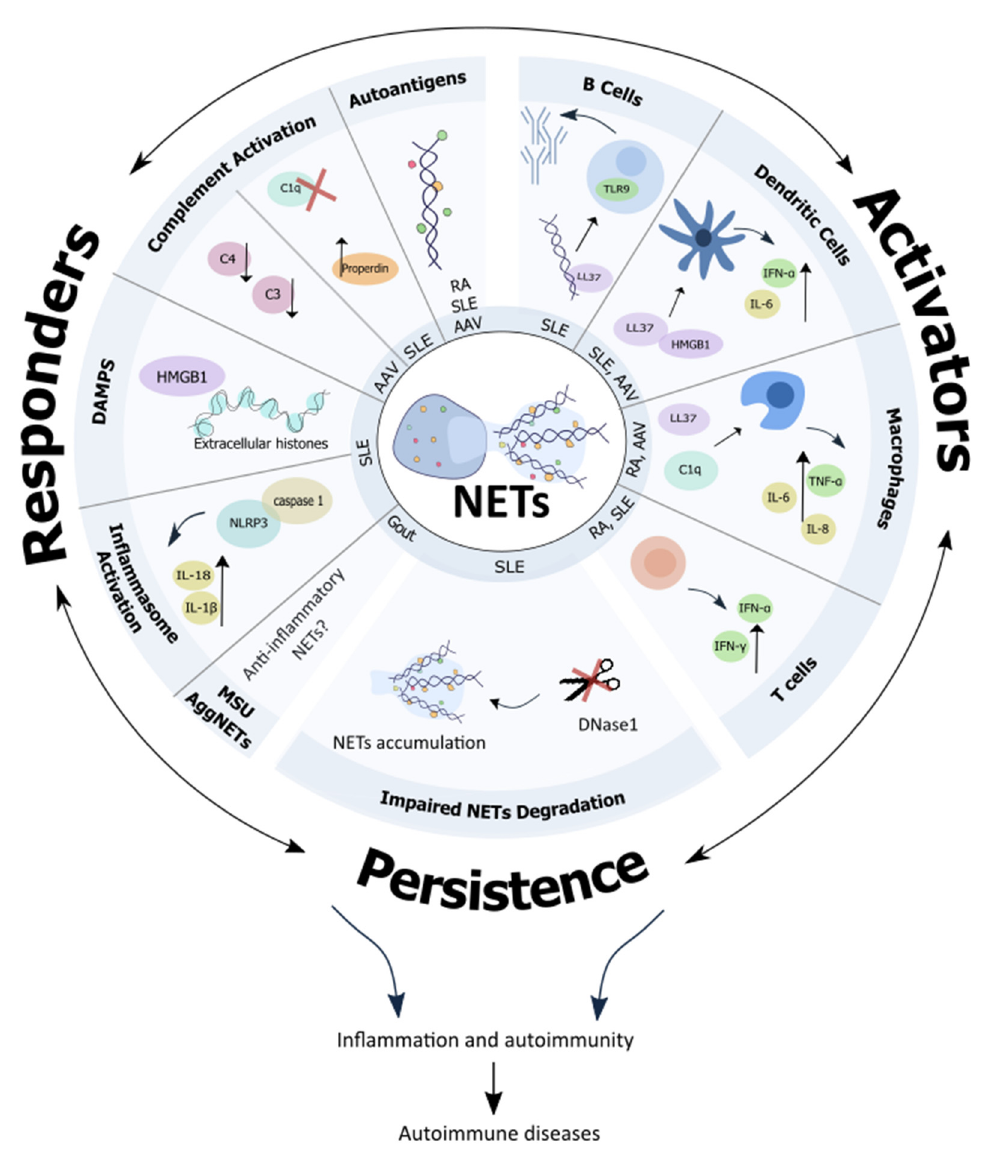
Figure 1. Neutrophil extracellular traps (NETs.) take the central stage in driving autoimmune responses. Abbreviations: AAV: Anti-neutrophil cytoplasmic antibodies associated vasculitis, ANCA: Anti-neutrophil cytoplasmic antibodies, C1q: complement factor 1q, C4: complement factor 3, C4: complement factor 4, DAMPs: damage associated molecular patterns, HMGB1: high mobility group box protein 1, IFN- α : interferon alpha, IFN- γ : interferon gamma, IL: interleukin, LL37: cathelicidin antimicrobial peptides, MSU: monosodium urate crystals, NETs: neutrophil extracellular traps, NLRP3: nucleotide-binding oligomerization domain-like receptor protein 3, RA: rheumatoid arthritis, SLE: systemic lupus erythematosus, TLR9: toll-like receptor 9, TNF- α : tumour necrosis factor